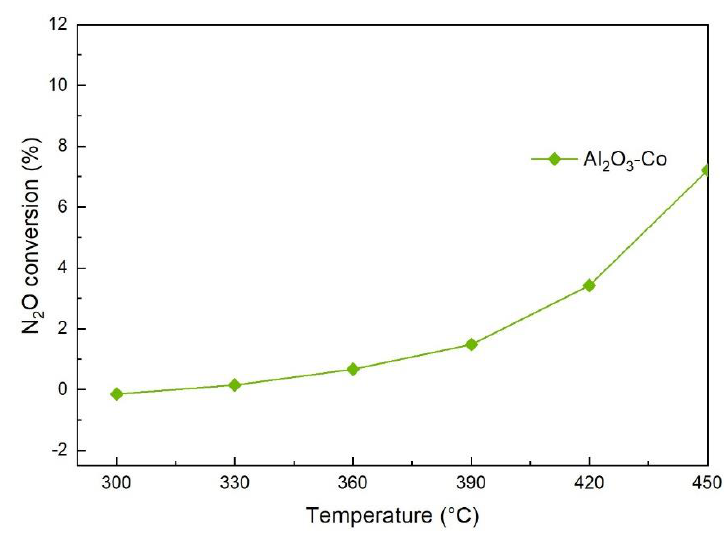
Figure A6. N 2 O conversion of Al 2 O 3 cobalt catalyst.